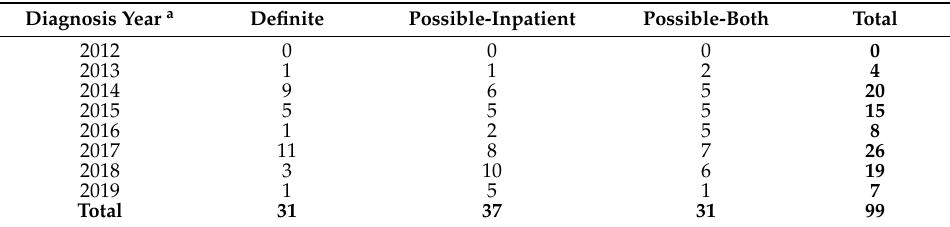
Table 3. VA LD cases, by case classifications and calendar year of